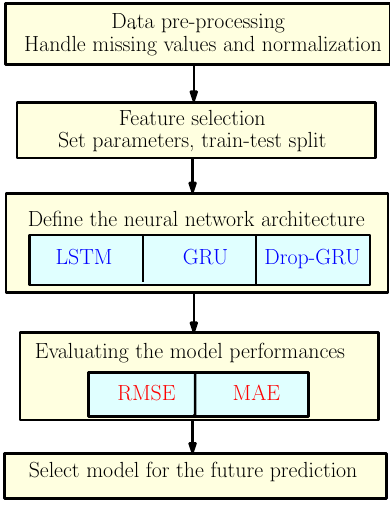
Figure 2. The Proposed Methodology.